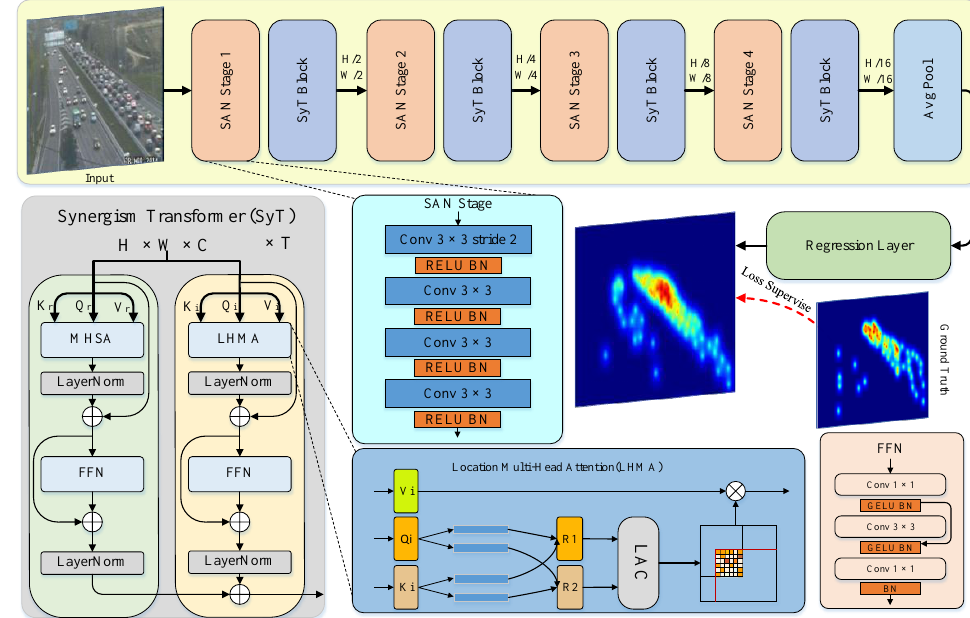
Figure 2. Overview of our synergism attention network (SAN)